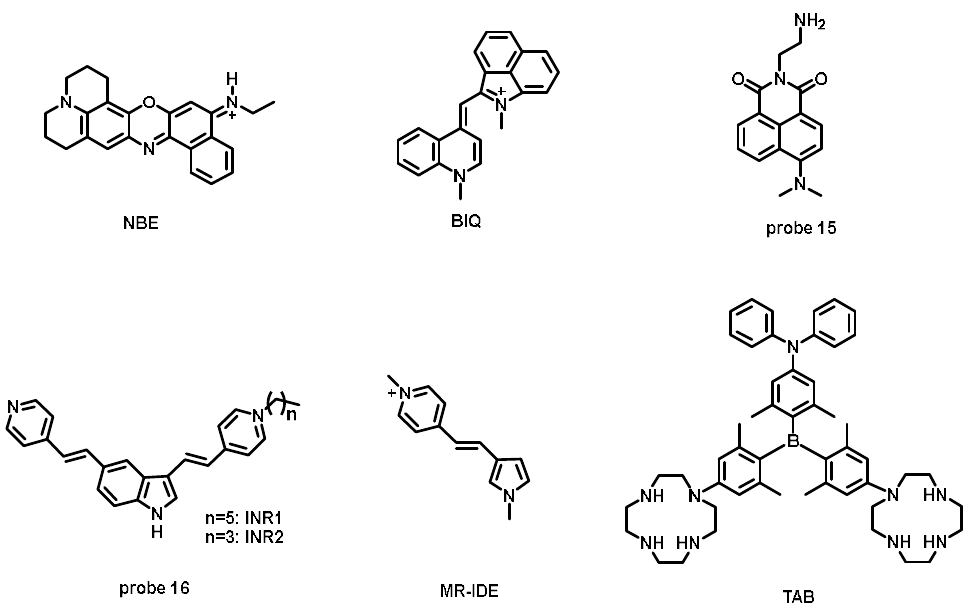
Figure 14. Structures of fluorescent probes for RNA detection.